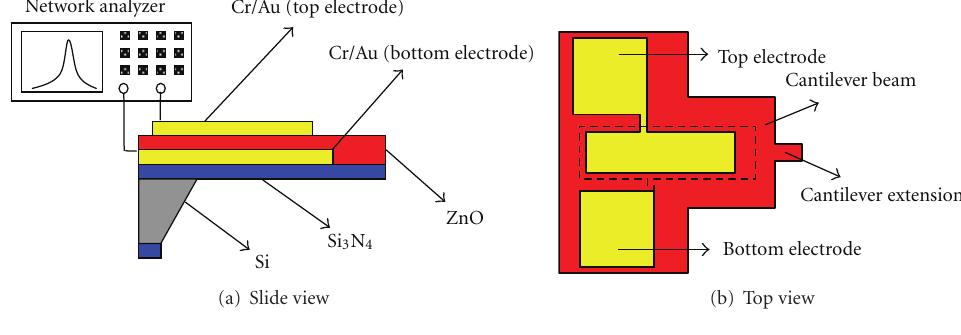
Figure 1: Schematic drawing of the sensor.